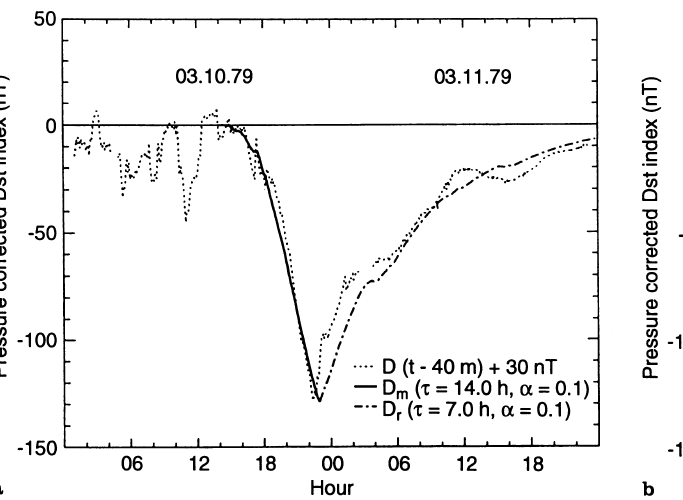
s (cid:136) s m (cid:136) 14 : 0 h. The dot-dashed line (cid:133) D r (cid:134) corresponds to the numerical integration of Eq. (3), starting at the peak for D (cid:133) 0 (cid:134) (cid:136) D p and s (cid:136) s r (cid:136) 7 : 0 h. The respective shifts in time and zero level for D (t) are also shown in the legends. b Same as a , except for a (cid:136) 0 :